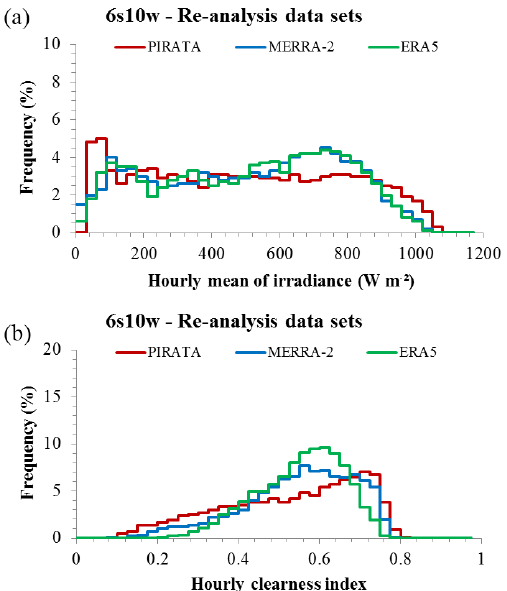
Figure 7. Frequency distributions of PIRATA measurements (red) and data sets (MERRA-2: blue, ERA5: green) at 6 ◦ S, 10 ◦ W for E (a) and KT (b) . If the coloured line is above (below) the red one for a given sub-range of values, it means that the data set produces these values too frequently (too rarely) with respect to the PIRATA measurements.